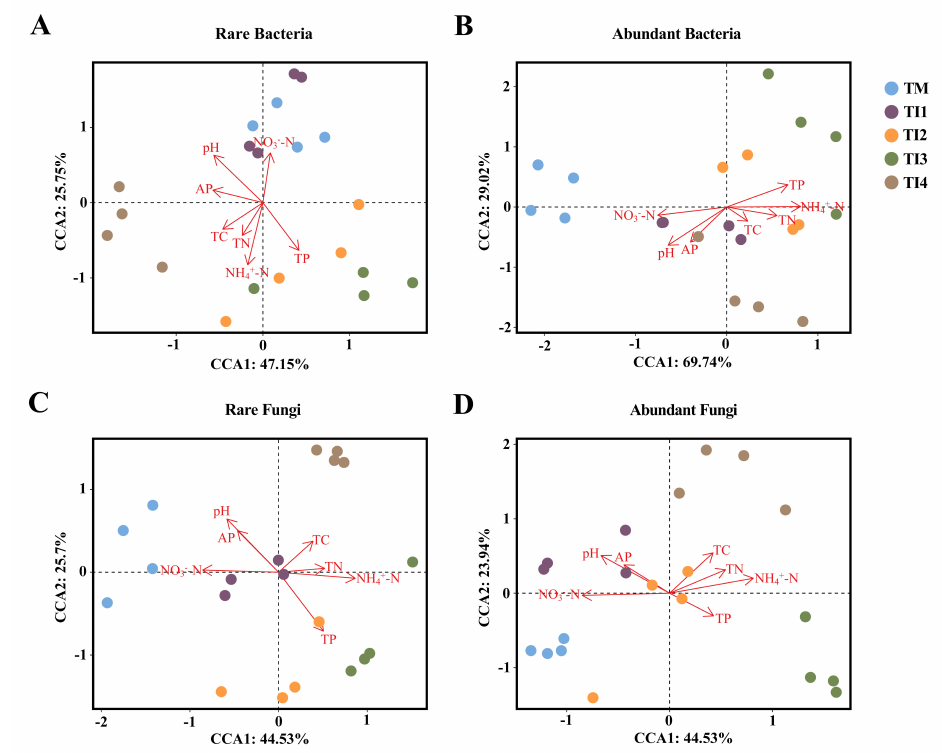
Figure 4. Canonical correspondence analysis (CCA) of soil properties and ( A ) rare and ( B ) abundant bacterial; and ( C ) rare and ( D ) abundant fungal community patterns. Treatments include tea-plant monoculture (TM), tea intercropping with soybean (TI1), tea intercropping with soybean—milk vetch (TI2), tea intercropping with soybean—red clover (TI3), and tea intercropping with soybean—smooth vetch